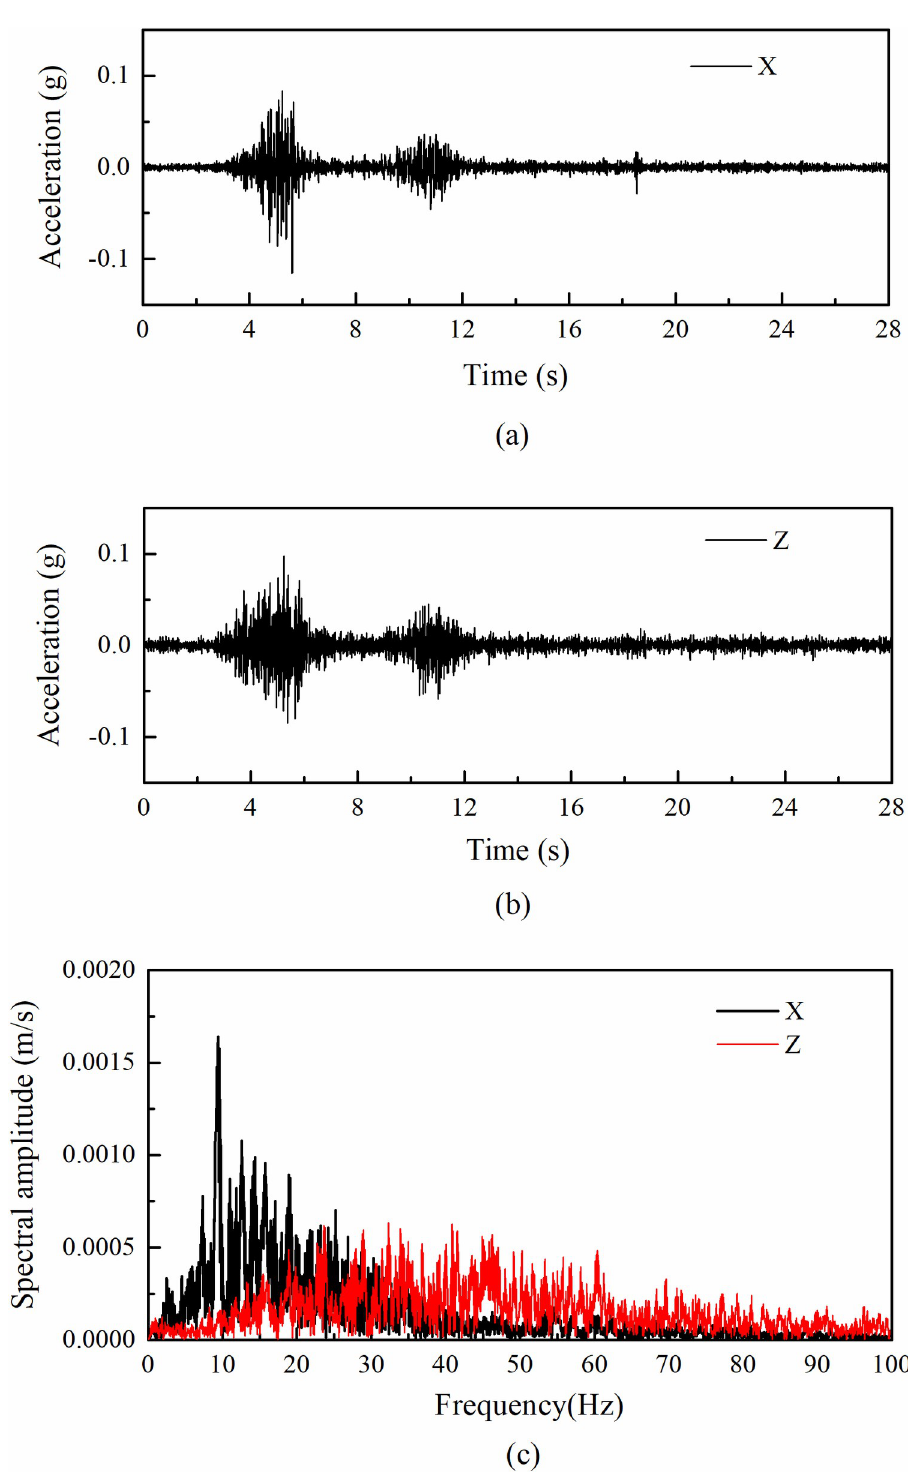
Fig 3. Input ground motion in shaking table tests for the case of 0.1 g input amplitude: (a) horizontal acceleration time histories; (b) vertical acceleration time histories; (c) corresponding Fourier spectrum.